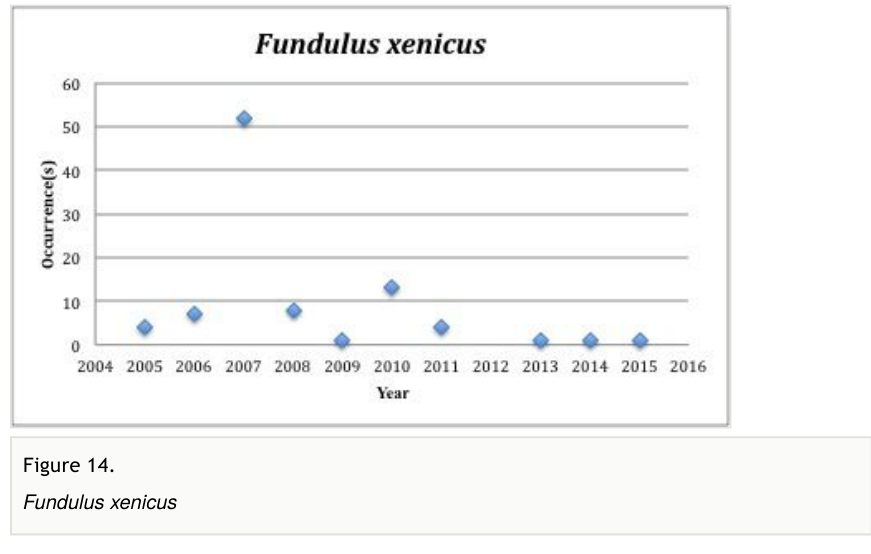
Figure 14. Fundulus xenicus